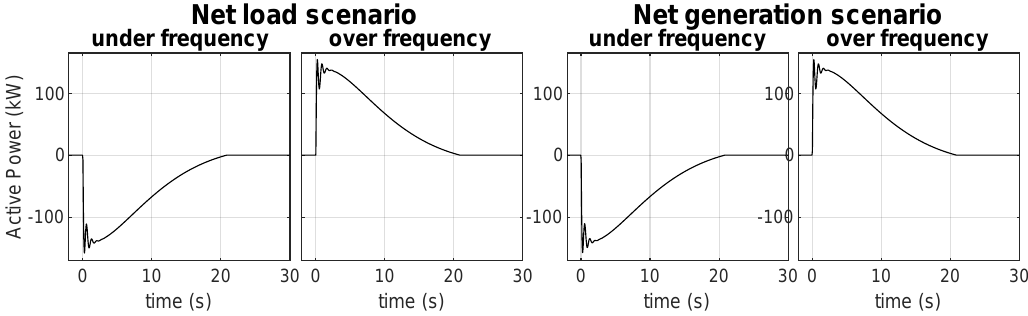
Figure 22. Active power variation in the local ESS. Positive values represent power consumption (ESS charging). Positive values correspond to power